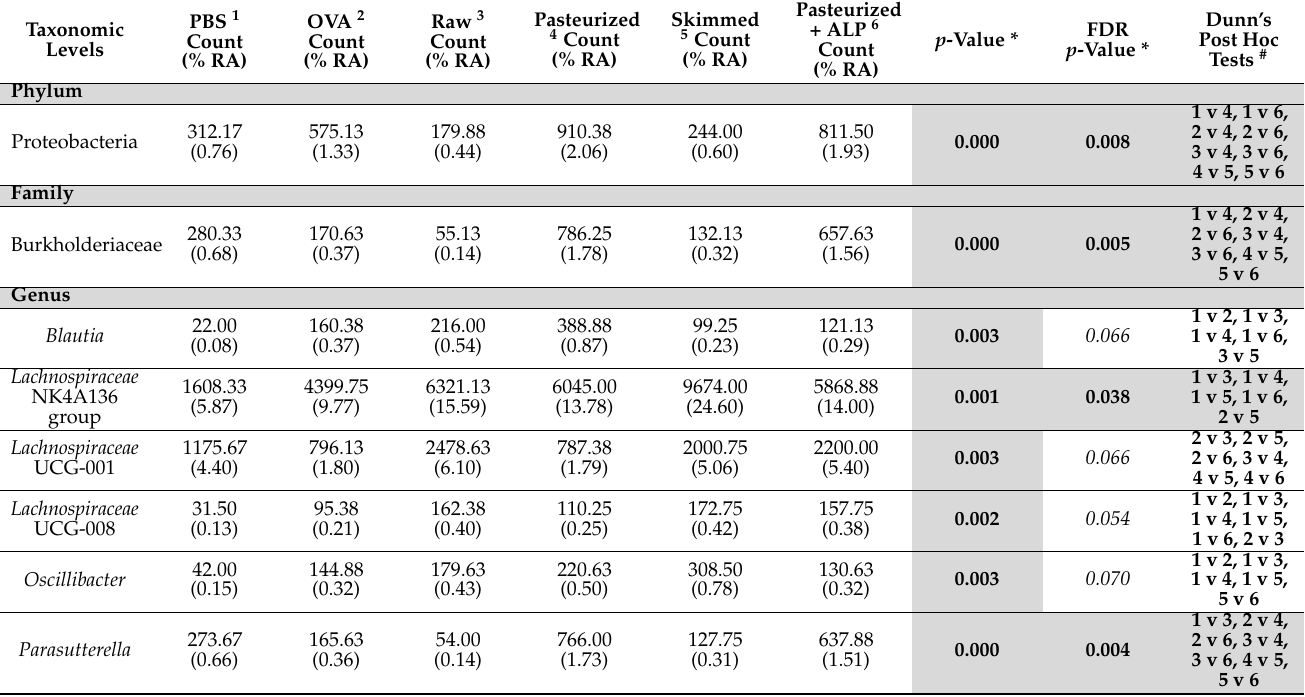
Table 2. Significant average total count and percent relative abundance of sequences of individual fecal taxa between the different groups at day